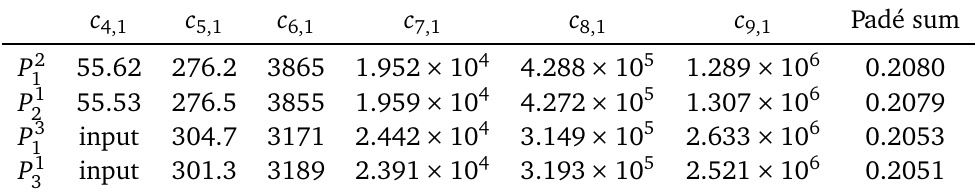
( a ) , and (lower-right panel) results from Q 2 ( 0 ) expansion of δ s FO